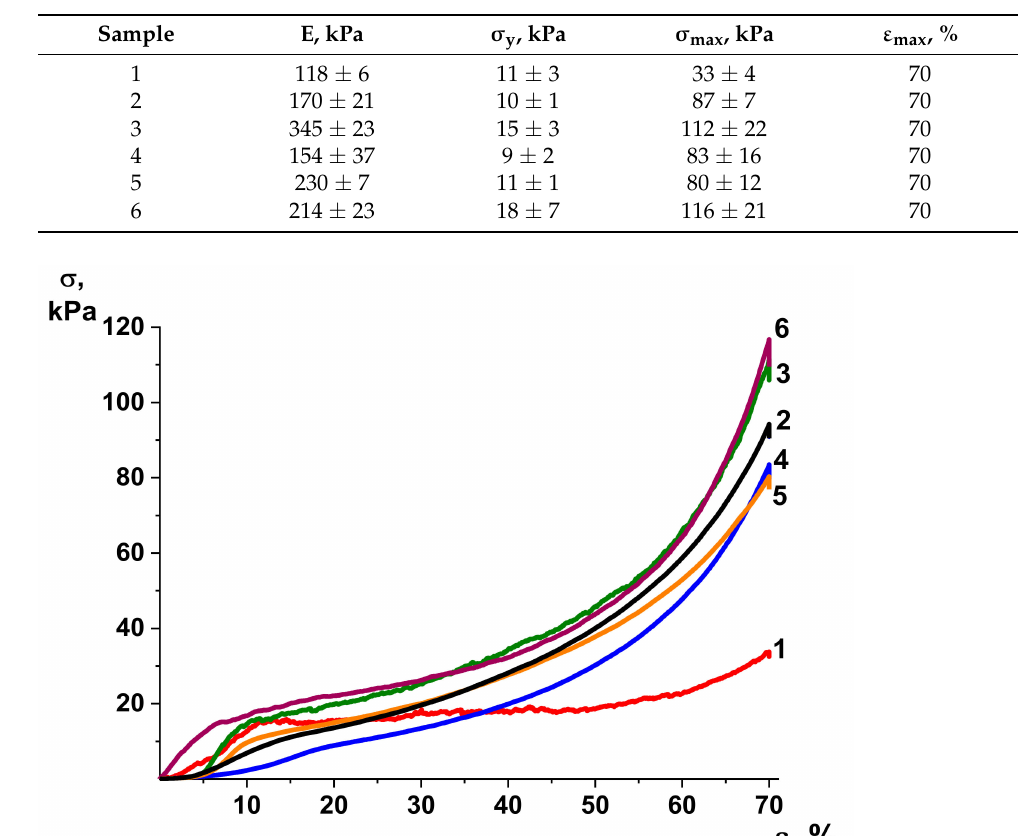
Table 2. Mechanical parameters of chitin cryogels, mean ± standard deviation, n = 3.